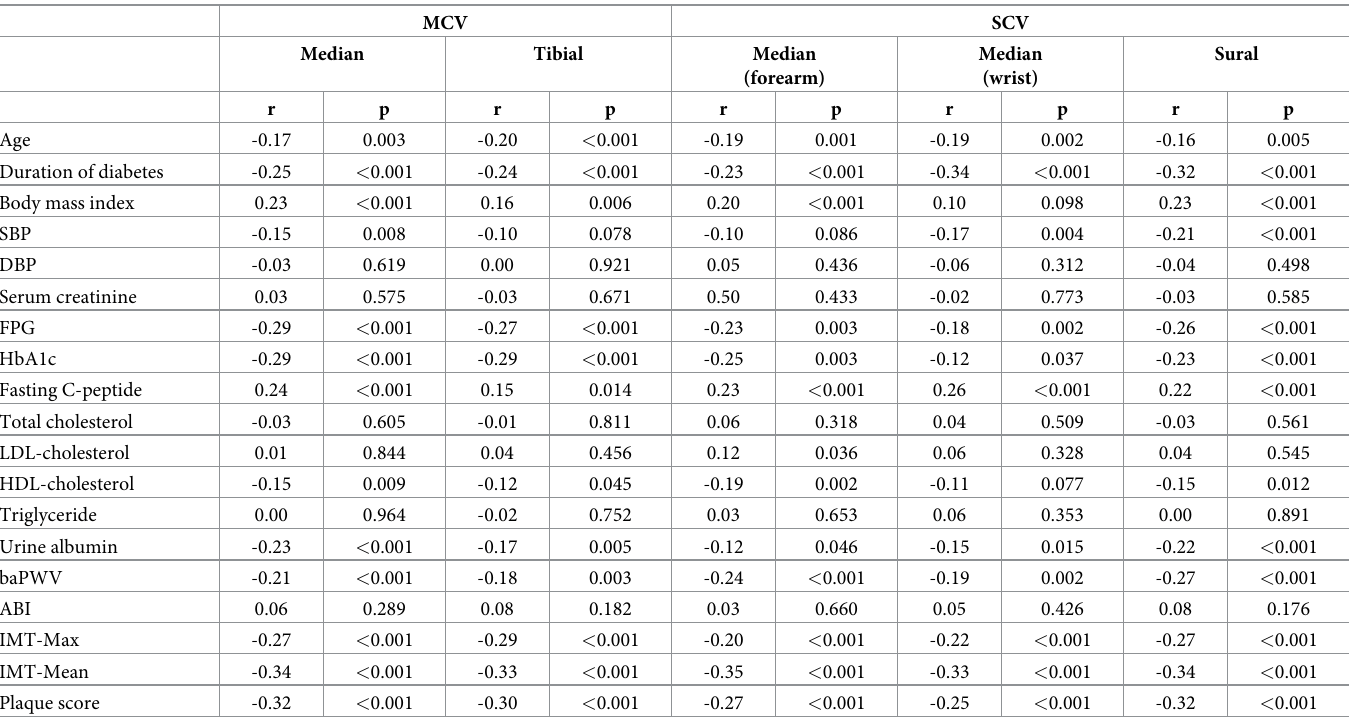
Table 2. Correlations between NCV and baseline